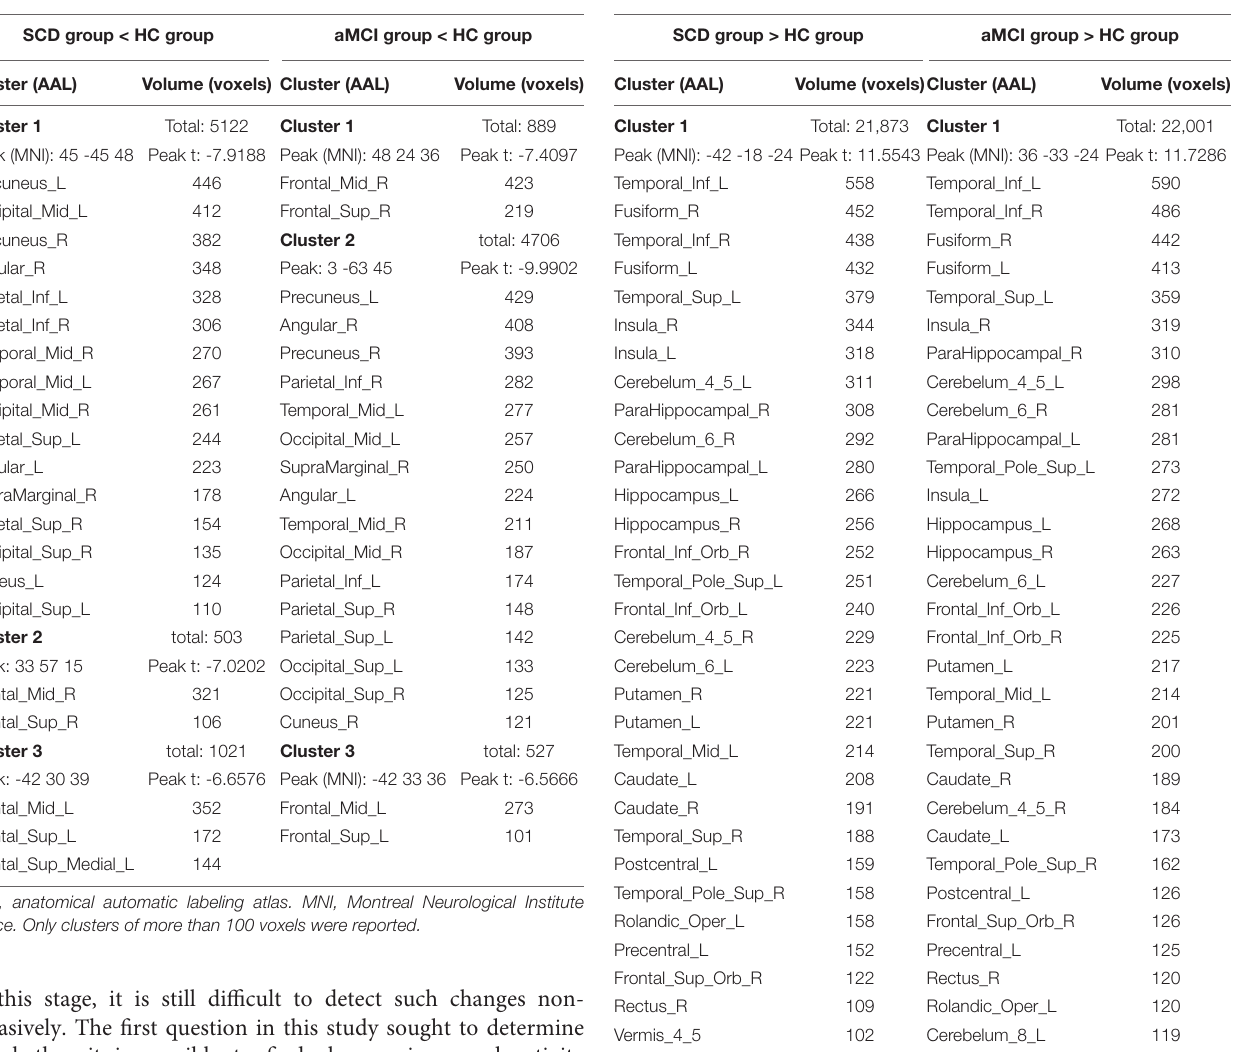
TABLE 4 | Brain regions with increased ReHo in the SCD group and the aMCI group compared to the HC